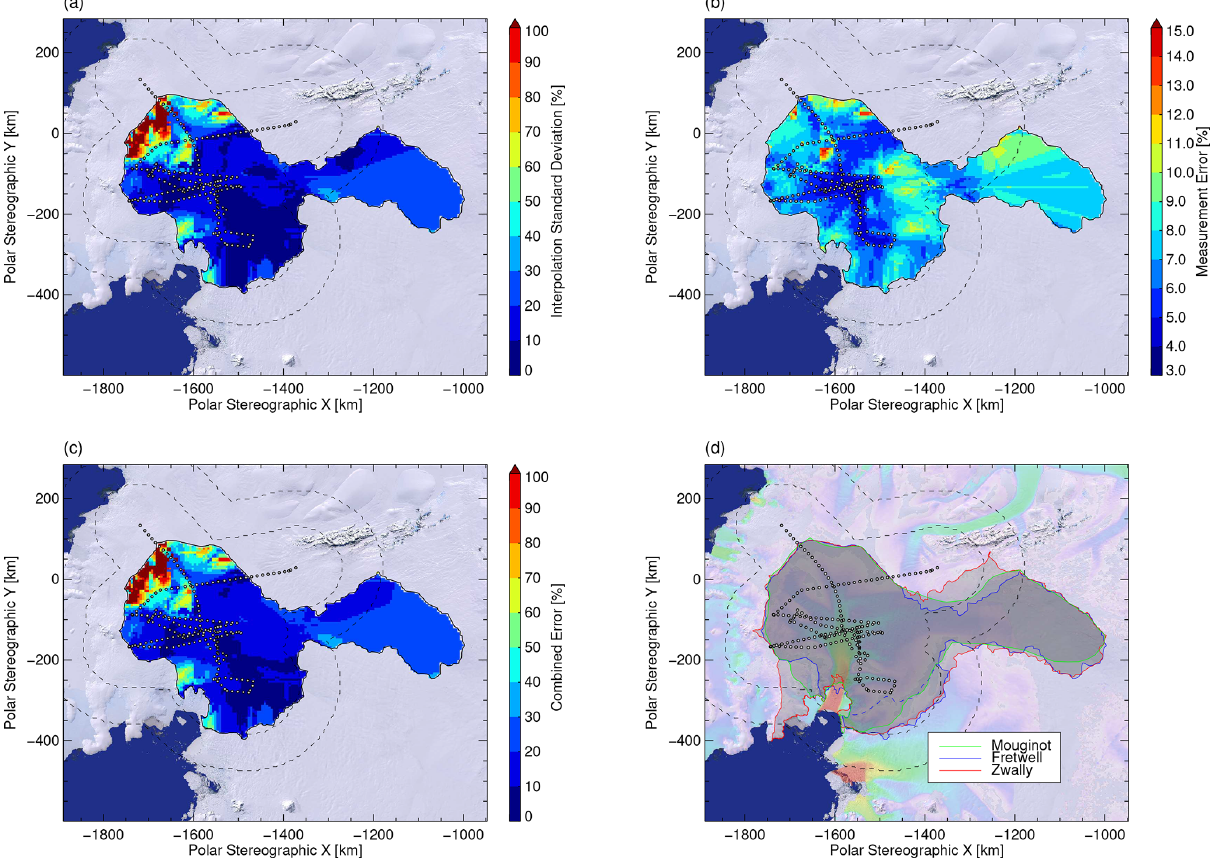
Figure 9. (a, b) Interpolation standard deviation S 0 and measurement error of Fig. 8a. (c) Root sum of squares of panels (a) and (b) . (d) Varying PIG basin definitions according to Zwally et al. (2012), Fretwell et al. (2013), and Mouginot et al. (2017). Surface flow speeds adopted from Fig. 1. Background imagery taken from U.S. Geological Survey (2007) for all